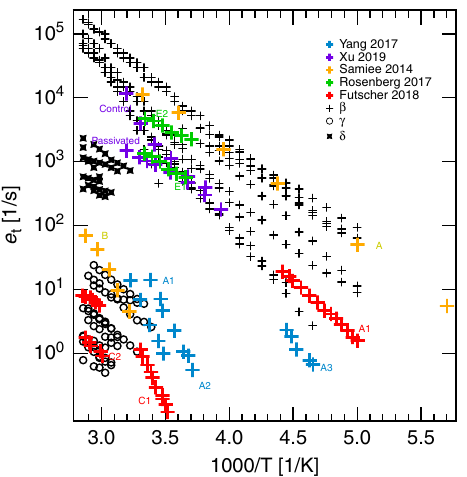
Fig. 5 Literature comparison. Migration rates reported in literature 30,34 – 36,38 (often called emission rates in the papers) were plotted in an Arrhenius diagram for comparison to our fi ndings (species β (crosses), γ (circles), δ (stars)). All reported emission rates can be associated with two regimes at low emission rates and high temperatures and at high emission rates at high and middle temperatures.